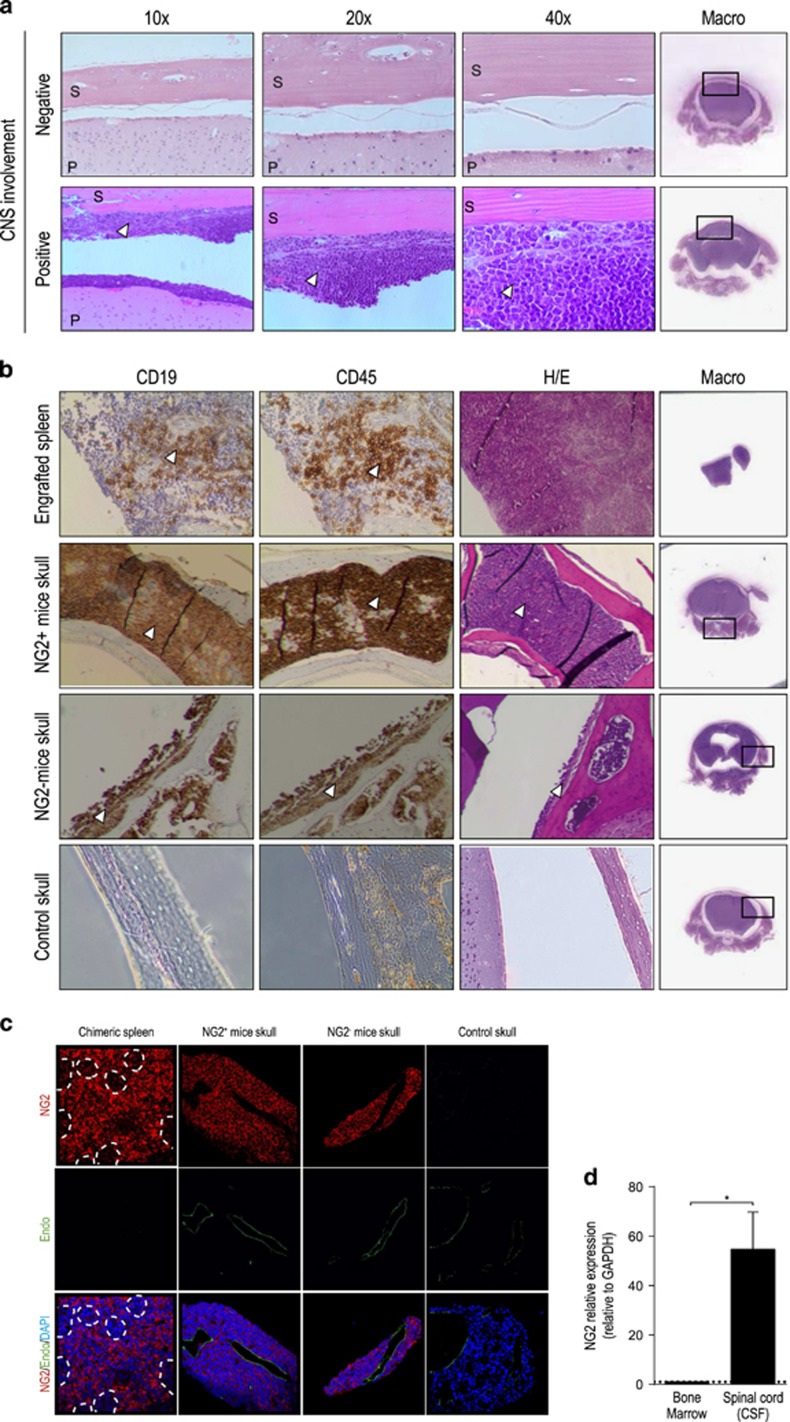
NG2 is not a prospective marker for CNS-IC but it is expressed in almost all MLLr blasts entering the CNS. (a) Representative H&E staining of mice brains defining xenografts with negative and positive CNS involvement (n=60). S, skull. P, brain parenchyma. Leukemic infiltration is exclusively found in leptomeninges and is marked by a white arrowhead. The right panel (macro) depicts the area magnified on each row. (b) H&E staining and immunohistochemistry for CD19 and CD45 performed on paraffin-embedded skulls from mice transplanted with NG2+ and NG2− blasts (n=60). Chimeric spleens and skulls from non-engrafted mice were used as positive and negative controls, respectively. CD45+CD19+ human blasts are marked with a white arrowhead. (c) Immunofluorescence staining for NG2, endomucin (endothelial vessel marker) and DAPI on chimeric spleen, NG2+ and NG2− transplanted mice skull and control skull (non-engrafted mice). Dot lines delimit areas with high density of cells and low density of NG2 marker in the chimeric spleen. Almost a 100% of human blasts in the CNS are consistently NG2+, regardless of the NG2 phenotype of the population transplanted. (d) RT-qPCR showing 55-fold higher expression of NG2 in the spinal cord than in BM. *P<0.05.